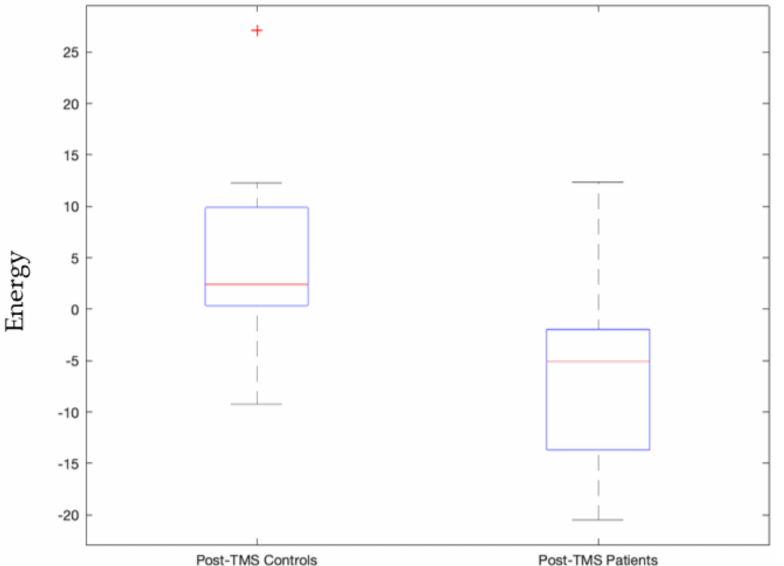
Figure 3. Energy values of controls significantly differed from patients during post-TMS subthreshold pulse stimulation condition with a p -value = 0.00003 for the sensorimotor network energy state where left precentral and postcentral gyrus along with paracentral lobule are actively bonded together in terms of connectivity. TMS subthreshold pulse was administered at the left motor